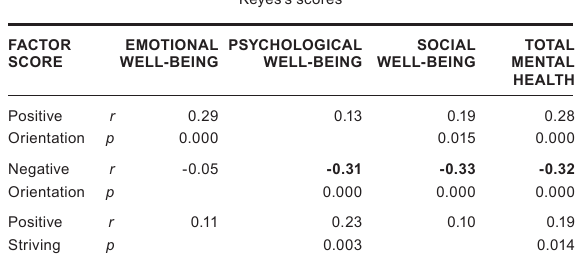
TABLE 4 Correlations between factor scores of organisationally relevant variables and Keyes’s